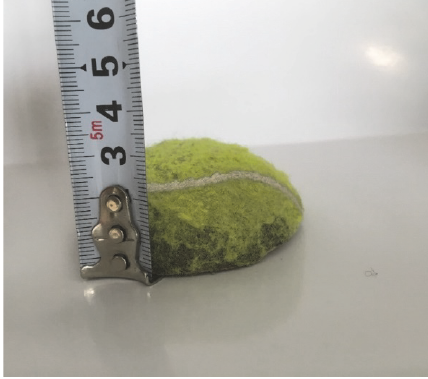
Figure 12: Height of the actual